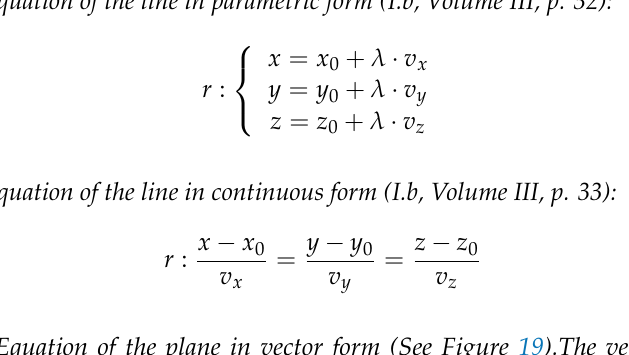
Figure 18. Geometric interpretation of the line equation in vector form